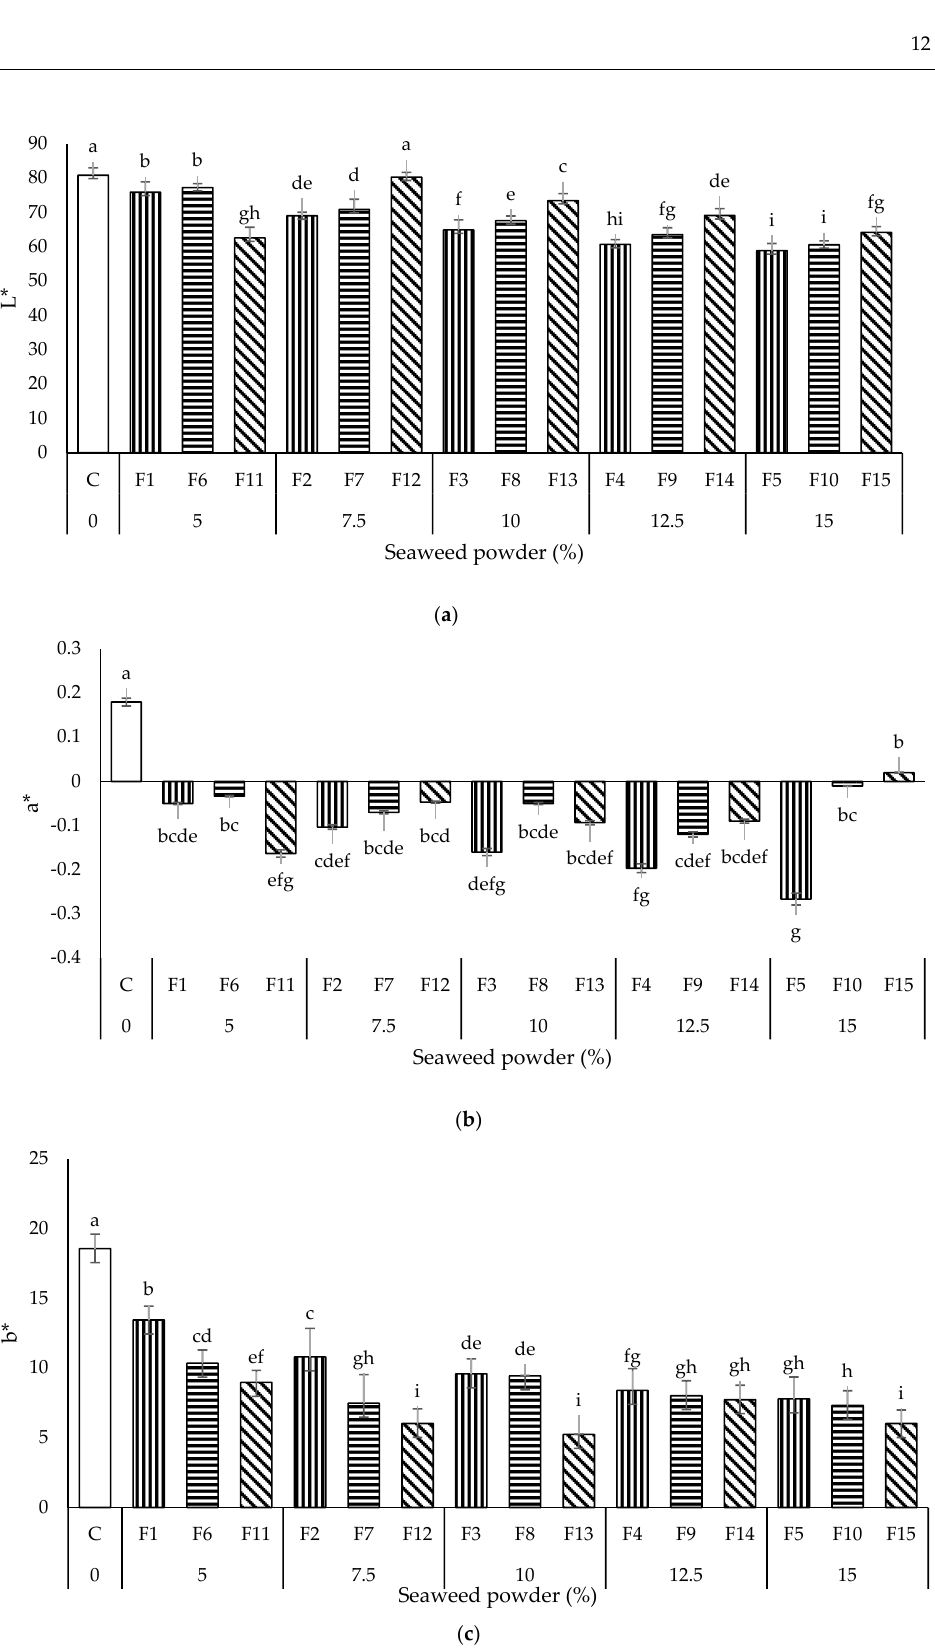
Figure 5. Color measurement ( a ) L* (lightness), ( b ) a* (redness/greenness), and ( c ) b* (yellow- ness/blueness) of all the noodles samples. Data are presented as mean ± standard deviation ( n = 3). a–i with different superscripts indicate the significant difference among the noodles samples (Tukey’s HSD, p < 0.05). Bars with vertical, horizontal, and diagonal patterns = wheat flour: potato starch ratios of 9:1, 8:2, and 7:3, respectively.